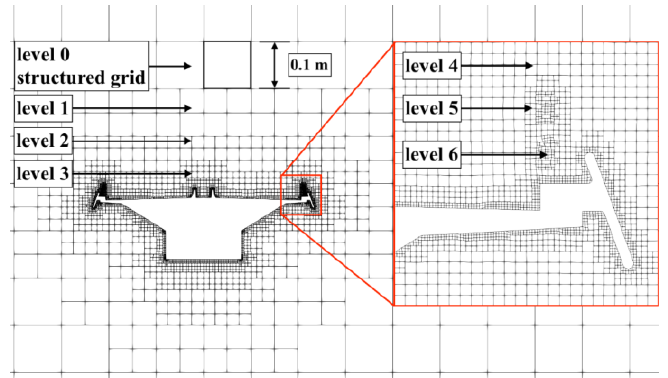
Figure 11. Details of mesh No.2.